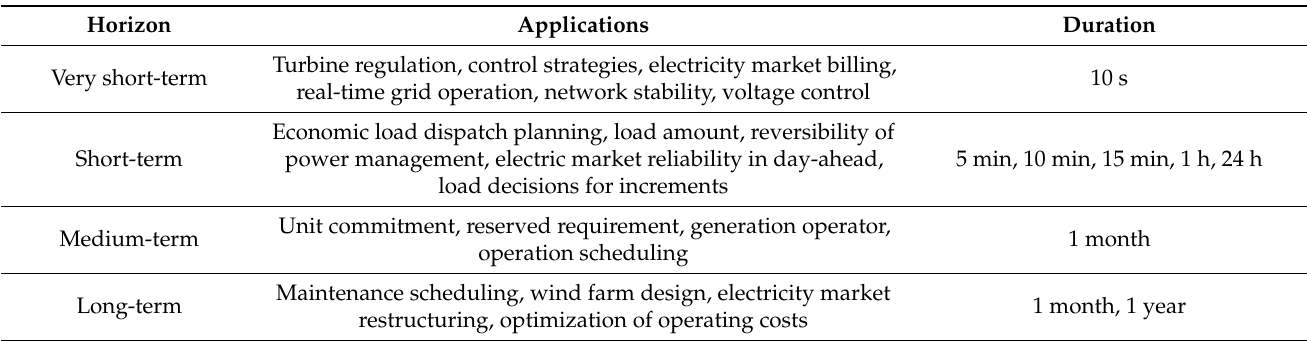
Table 1. Forecasting horizons.